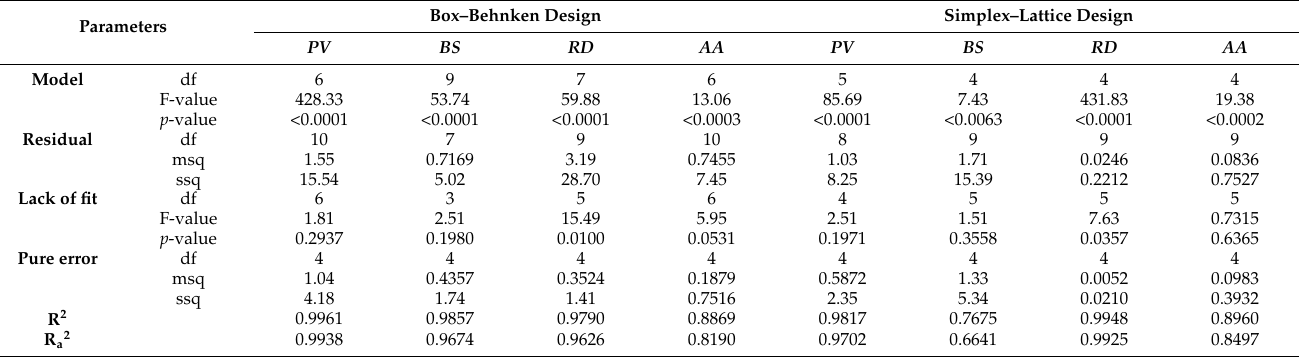
Table 7. ANOVA for the determination of model fitting (inhibition zone of extract